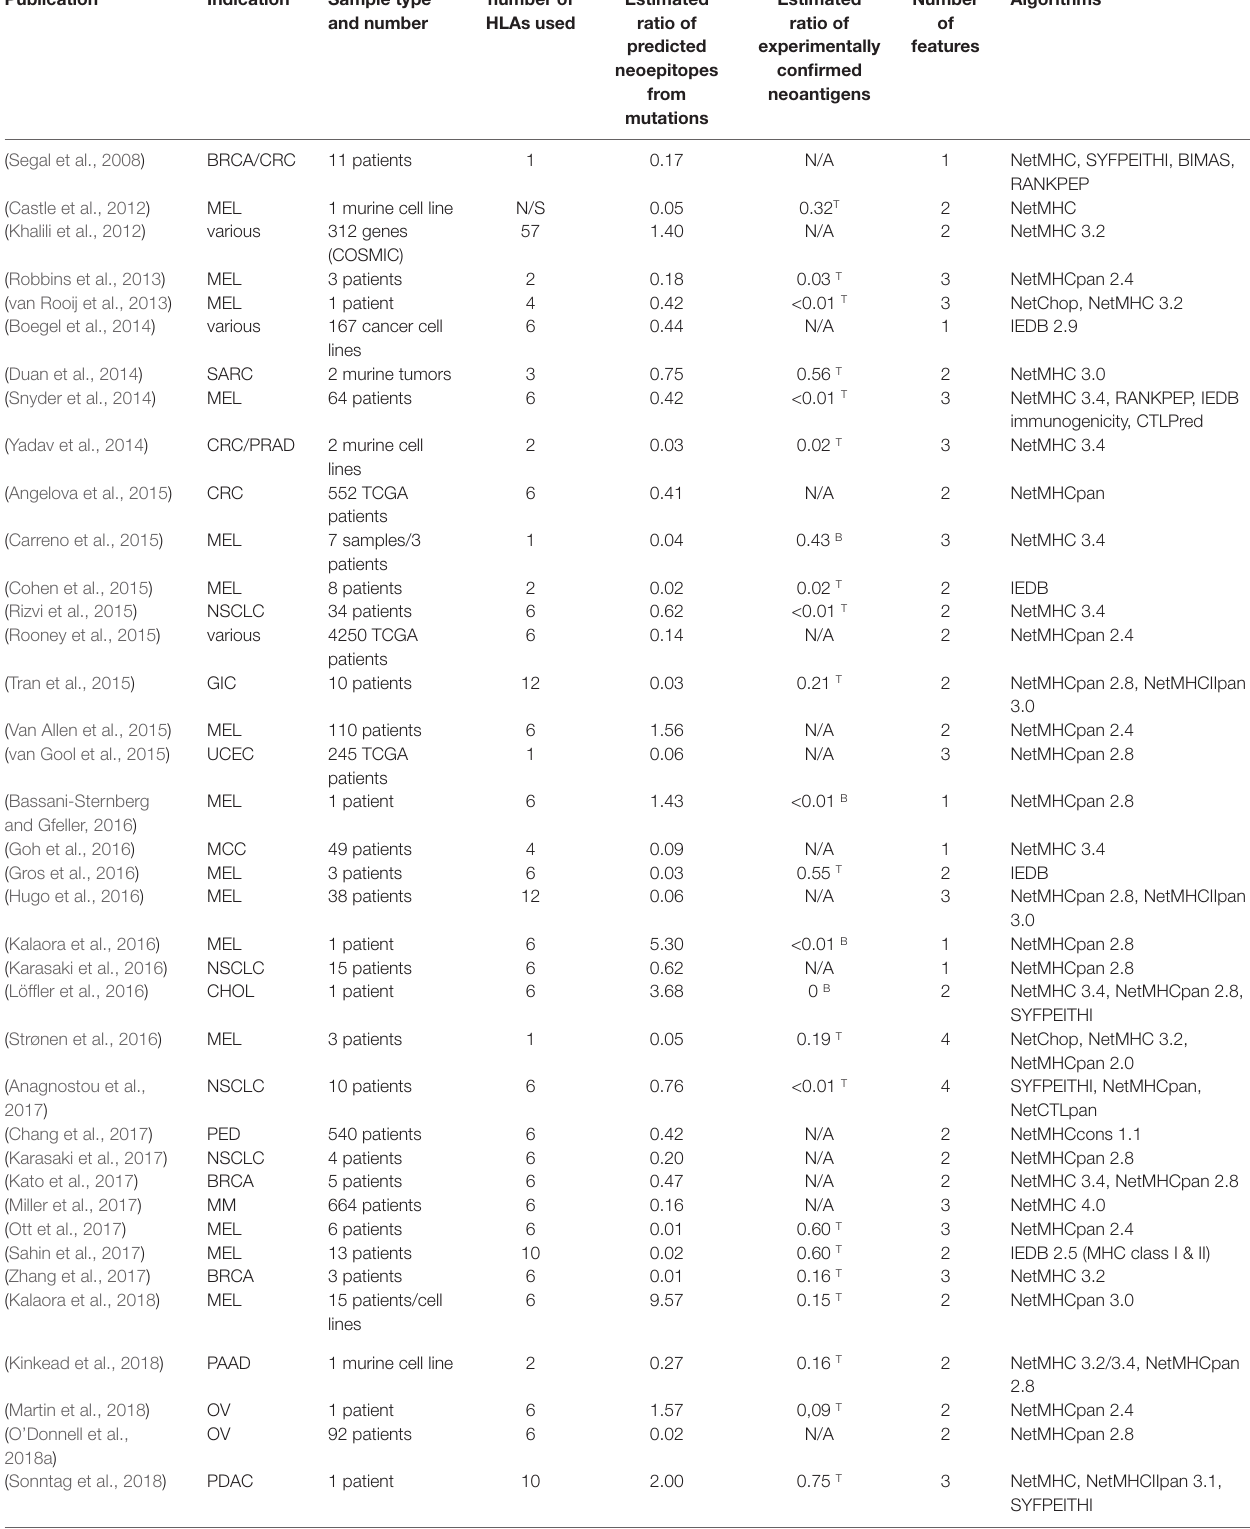
TABLE 1 | Publications describing the application of machine learning approaches to neoepitope